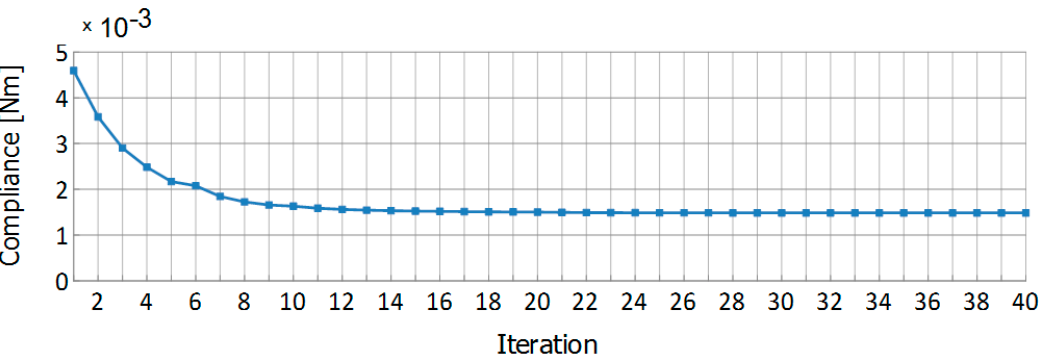
Figure 28. Selected middle topologies and the final one for the knee structure. For the last iteration the grid has not been shown to improve the clarity of the picture.